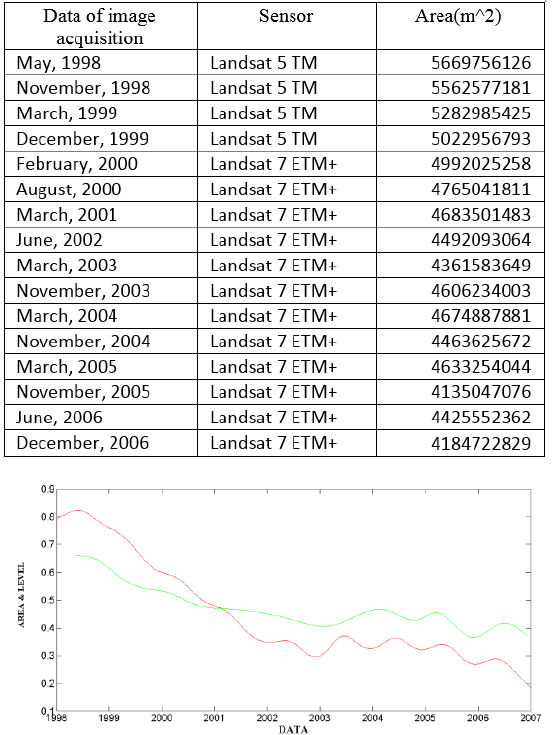
Table 1. Acquisition time of the images and the computed areas of the Lake surface.